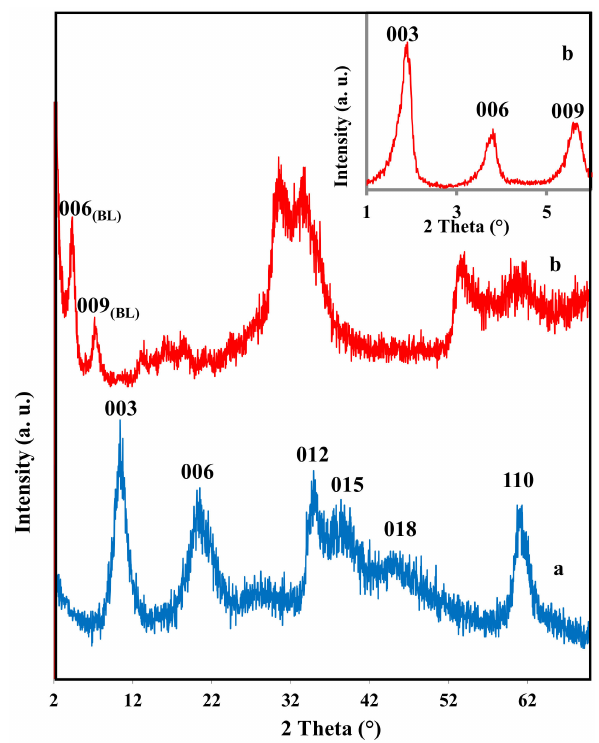
Figure 4. XRD patterns for Mg / Al-NO 3 LDH ( a ), LDH-BLE ( b ).